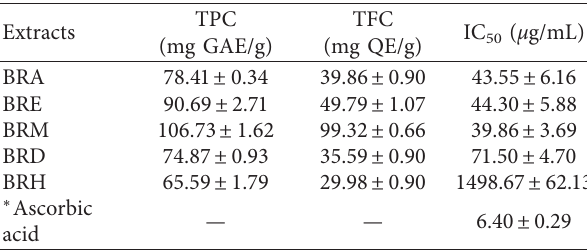
— — 6.40 ± 0.29 acid Values are the mean ± SD ( n � 3), ∗ Positive control.